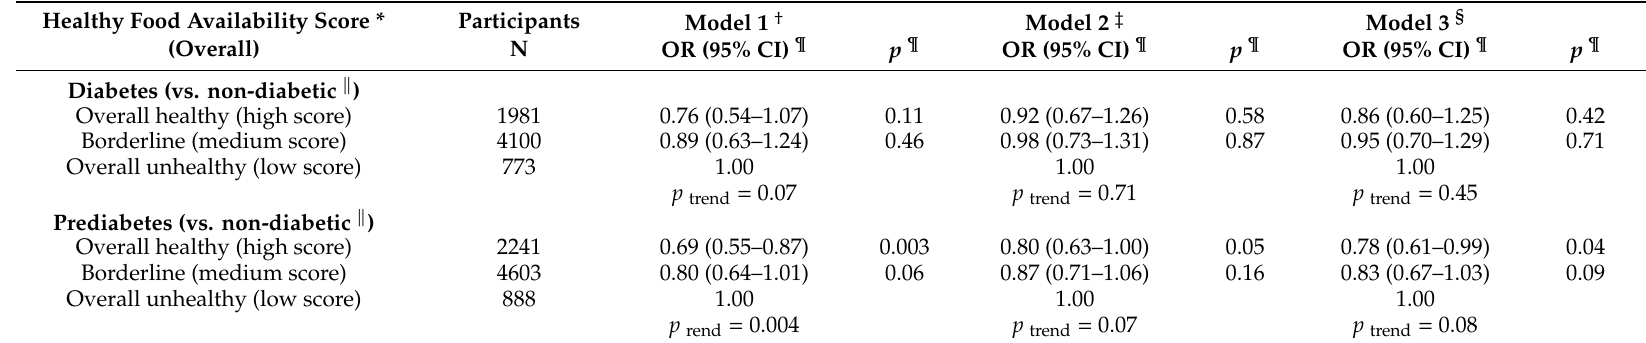
Table 3. Associations of overall home healthy food availability sores with diabetes and